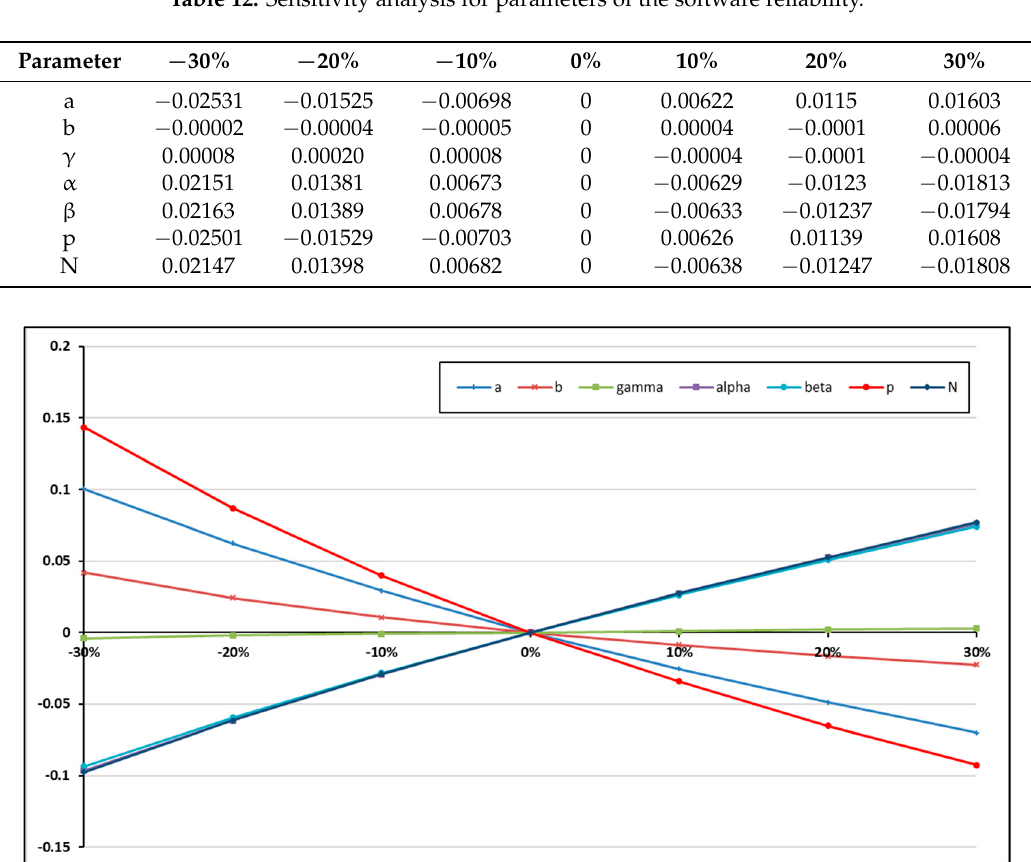
Table 12. Sensitivity analysis for parameters of the software reliability.